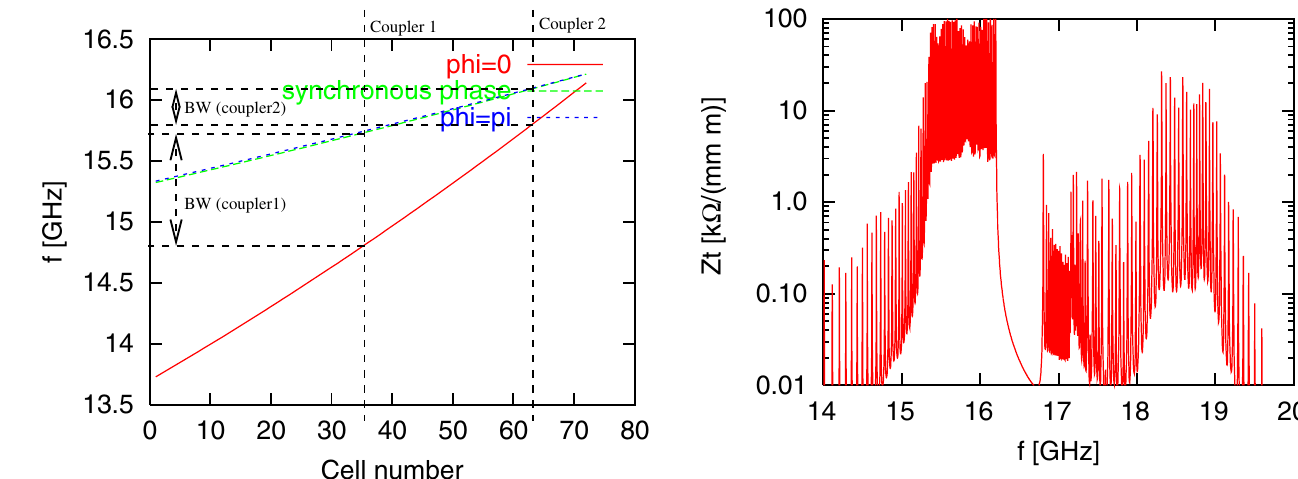
FIG. 6. (Color) Limits of lowest dipole band and synchronous frequency versus cell number. Also shown is the location of the wakefield couplers with their respective bandwidths.